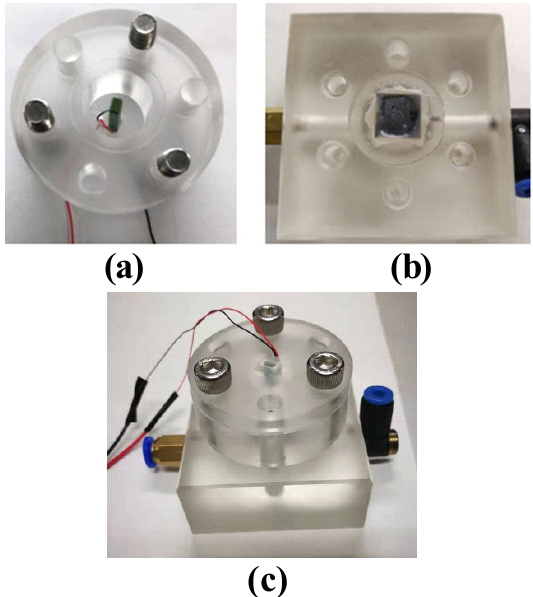
Figure 7. Photograph of the test structures. ( a ) The PMMA holder with the piezoelectric actuator. ( b ) The PMMA holder with the micro valve. ( c ) The whole structure after assembly.